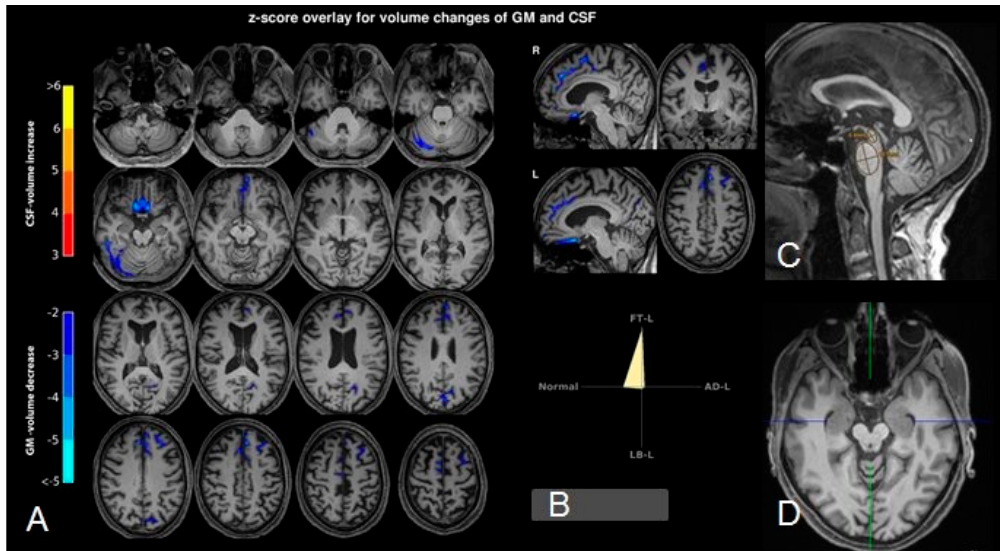
Figure 2. ( A ) Combined voxel- and region-based morphometry shows decreased gray matter volumes of the medial frontal lobes (z-scores < − 2 are displayed in blue to white). ( B ) A support vector machine suggests this pattern to be compatible with a fronto-temporal lobar degeneration. On visual analysis, the midbrain is atrophic ( C , D ), however the midbrain to pons ratio is (with 0.61) in the normal range ( D ).